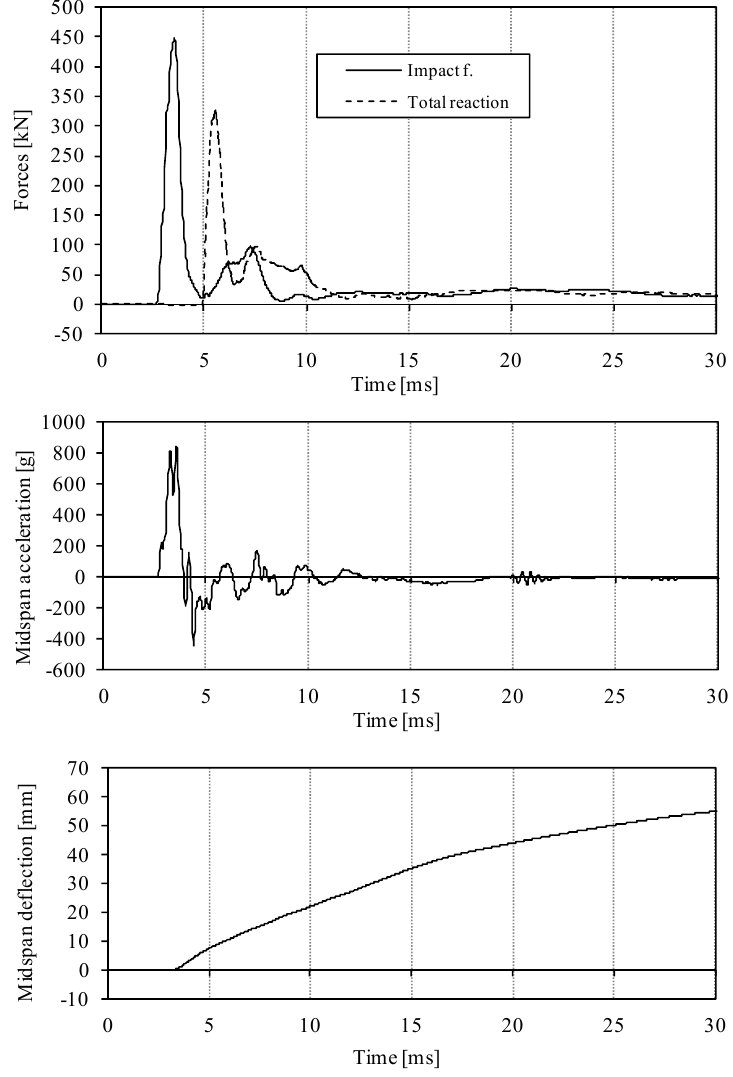
Figure 4. Dynamic measurements and midspan displacement over time for test RC-U0-IMP-1.